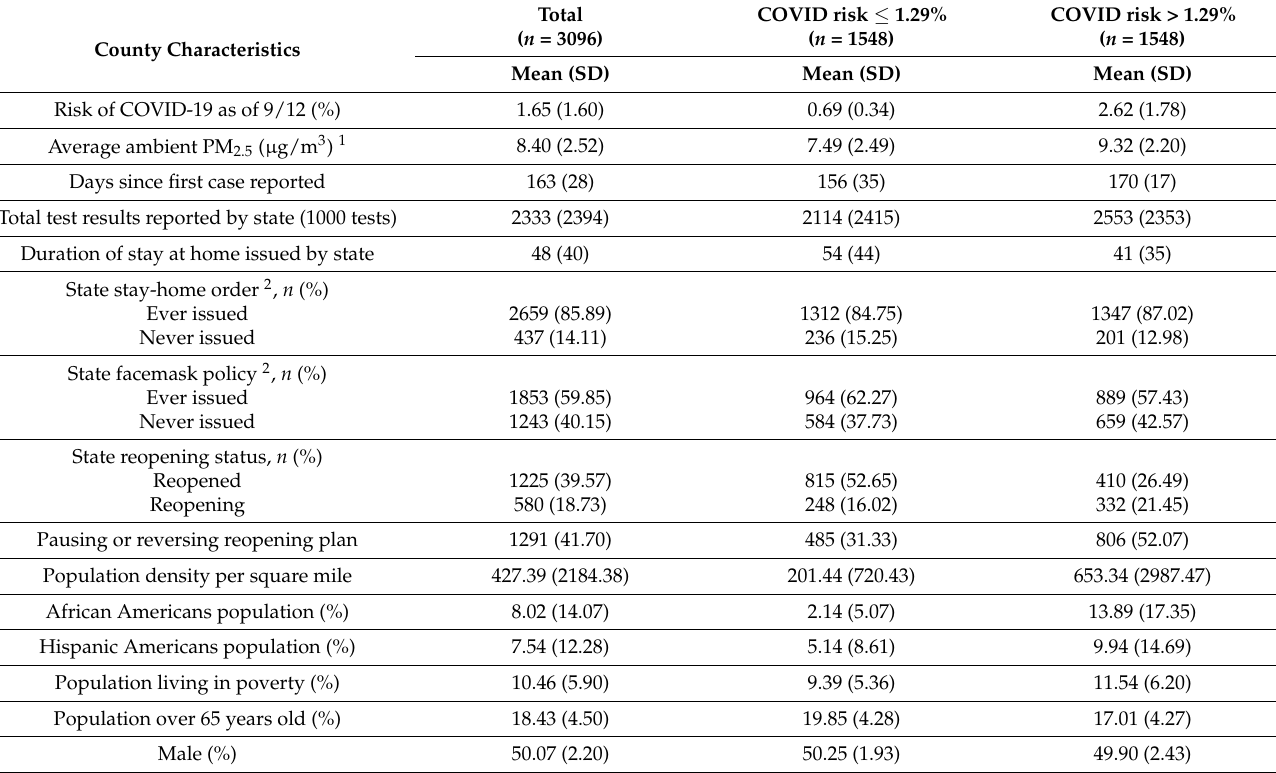
Table 3. Characteristics of Counties ( n = 3096) by COVID-19